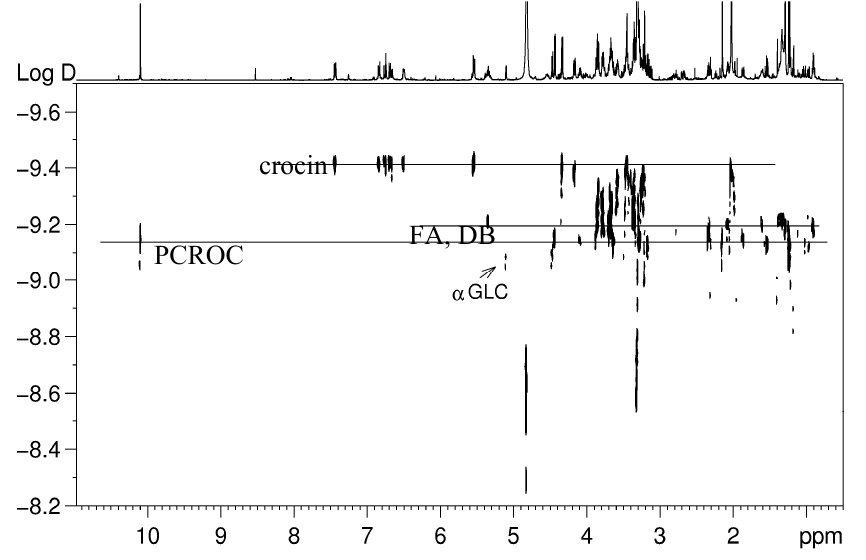
Figure 3. 2D DOSY map of saffron extract in CD OD at 27 °C. All signals from a given 3 molecule show the same diffusion coefficient as indicated for the case of crocin, fatty acids and picrocrocin. The 1 H spectrum of the extract is also reported as a horizontal